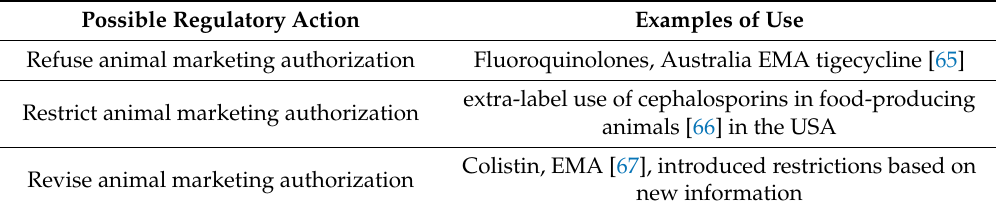
Table 1. Examples of possible animal regulatory actions triggered by concerns over resistance in human